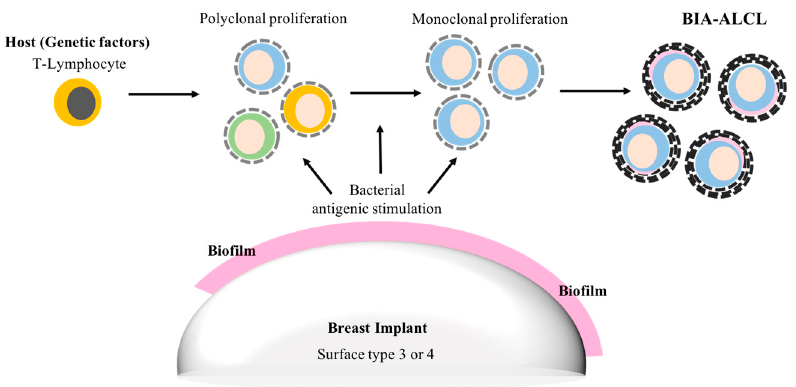
Figure 2. Suggested biofilm aetiopathogenesis of breast implant associated-anaplastic large cell lymphoma (BIA-ALCL).